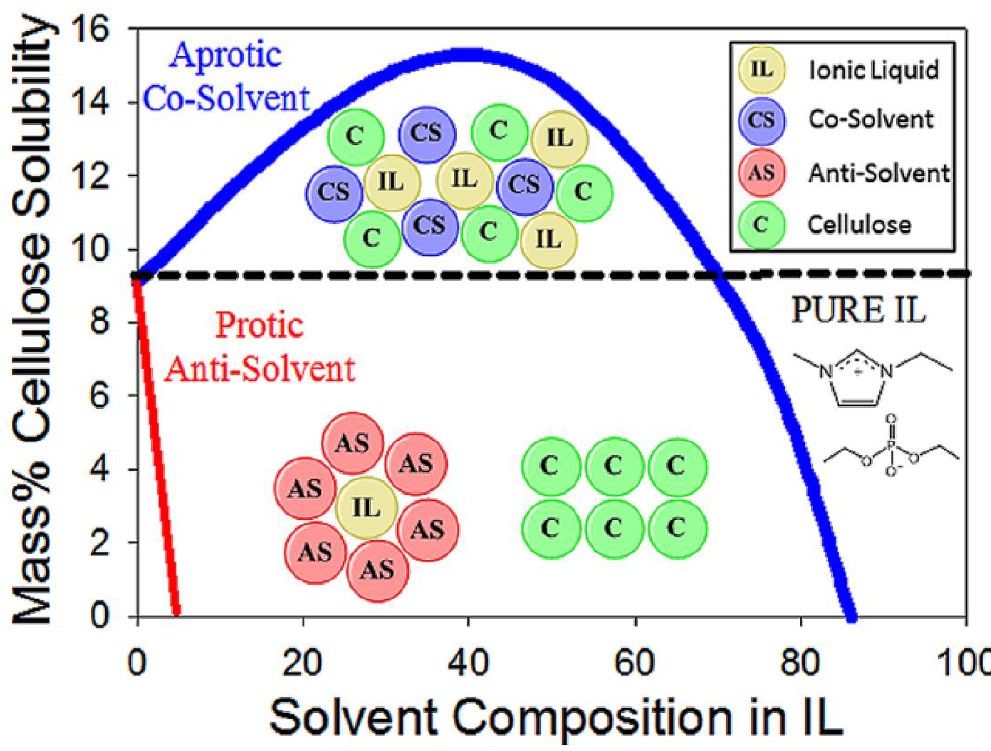
Figure 6. Preferential solvation of the IL ions by co-solvents and non-solvents. Preferential solvation of the IL ions with the non-solvent drives it out of the solvation layer of the biopolymers, leading to its precipitation, reproduced from [66], with permission from ACS,2016.